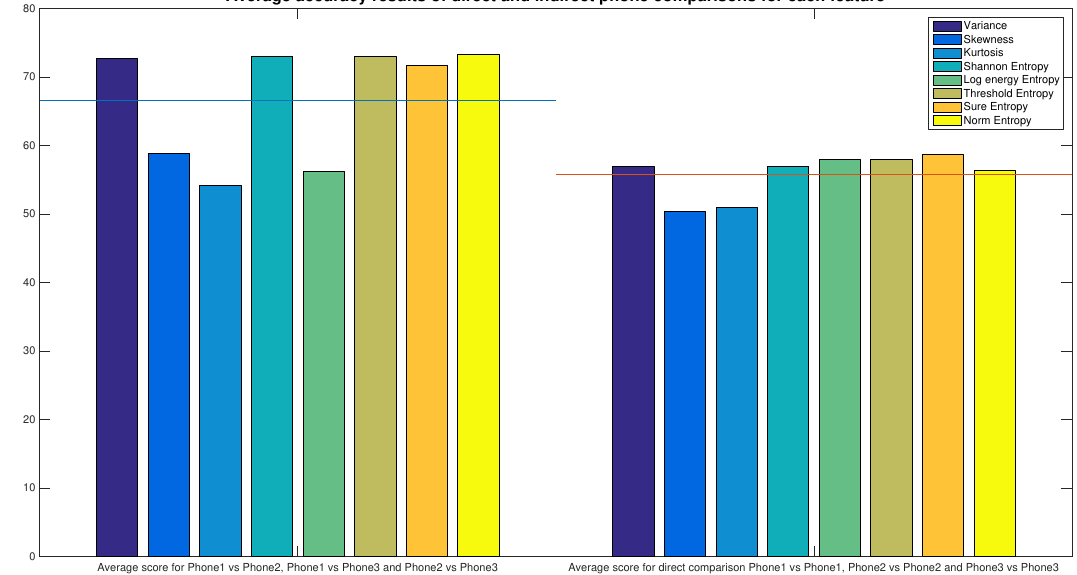
Figure 4. Average scores of comparison of each phone against each other and against itself for different features: horizontal lines show the average values for all the features (66.6 and 55.7,